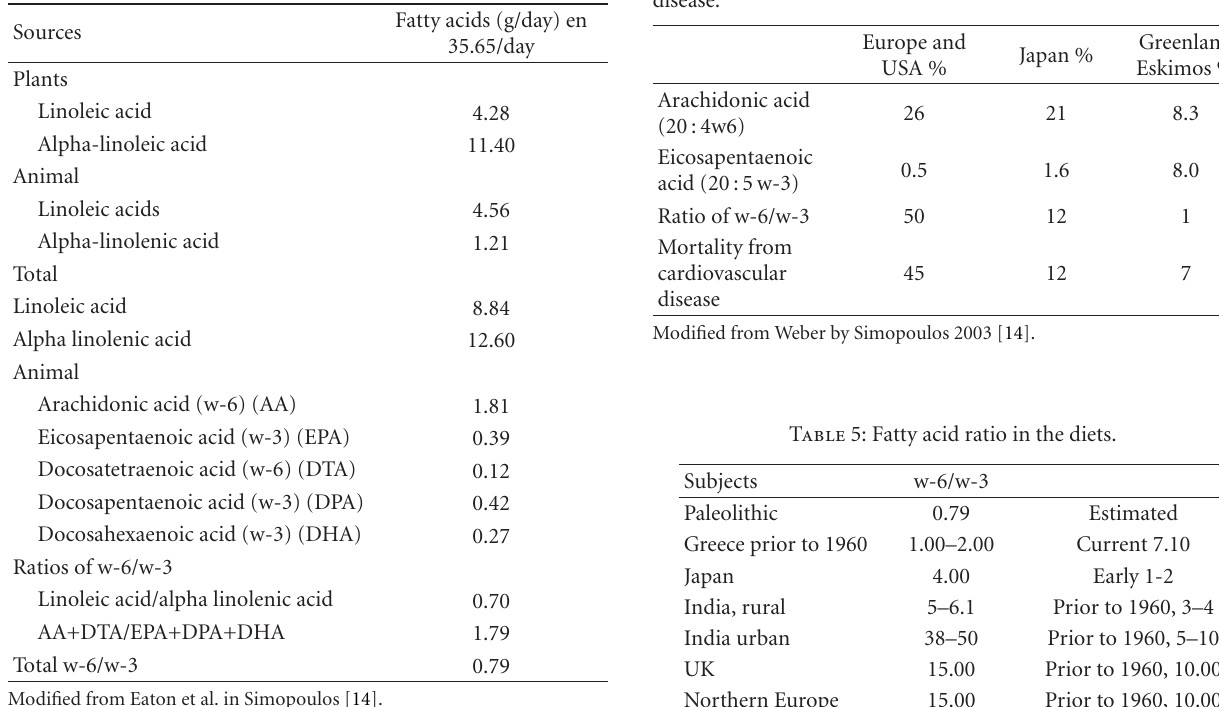
Table 4: Ethnic di ff erences in fatty acid levels in thrombocytes phospholipids and percentage of all deaths from cardiovascular disease.